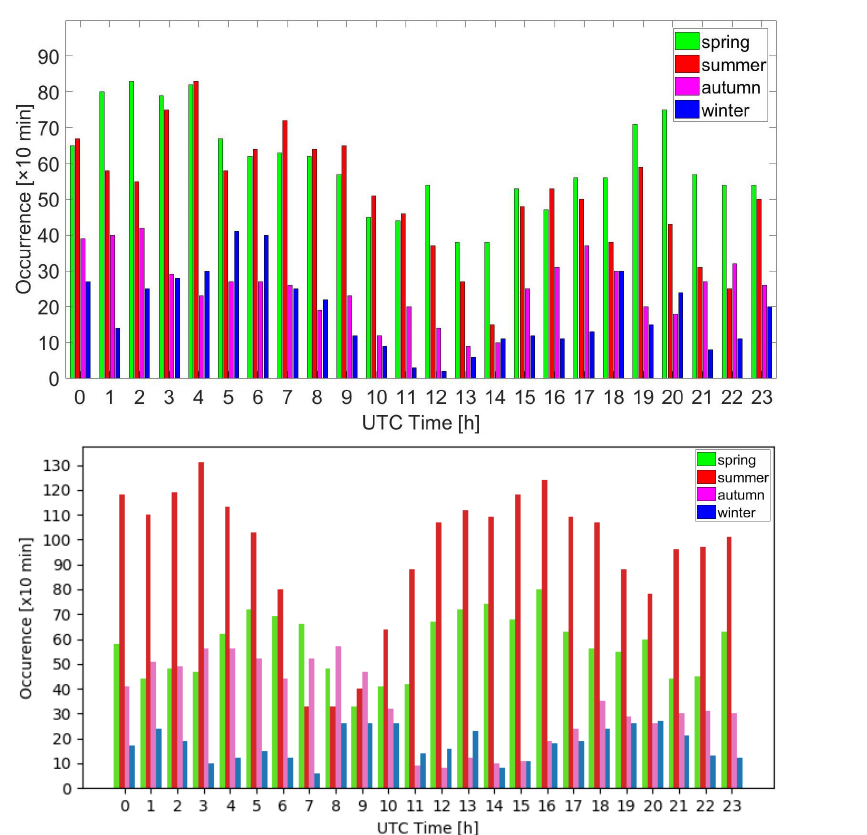
Figure 6. Total number of LLJ occurrence (10 min averages) in spring (green: March, April, May), summer (red: June, July, August), autumn (magenta: September, October, November) and winter (blue: December, January, February) at Heligoland ( upper figure ) and Norderney ( lower figure ) for each hour of the day in UTC based on wind lidar